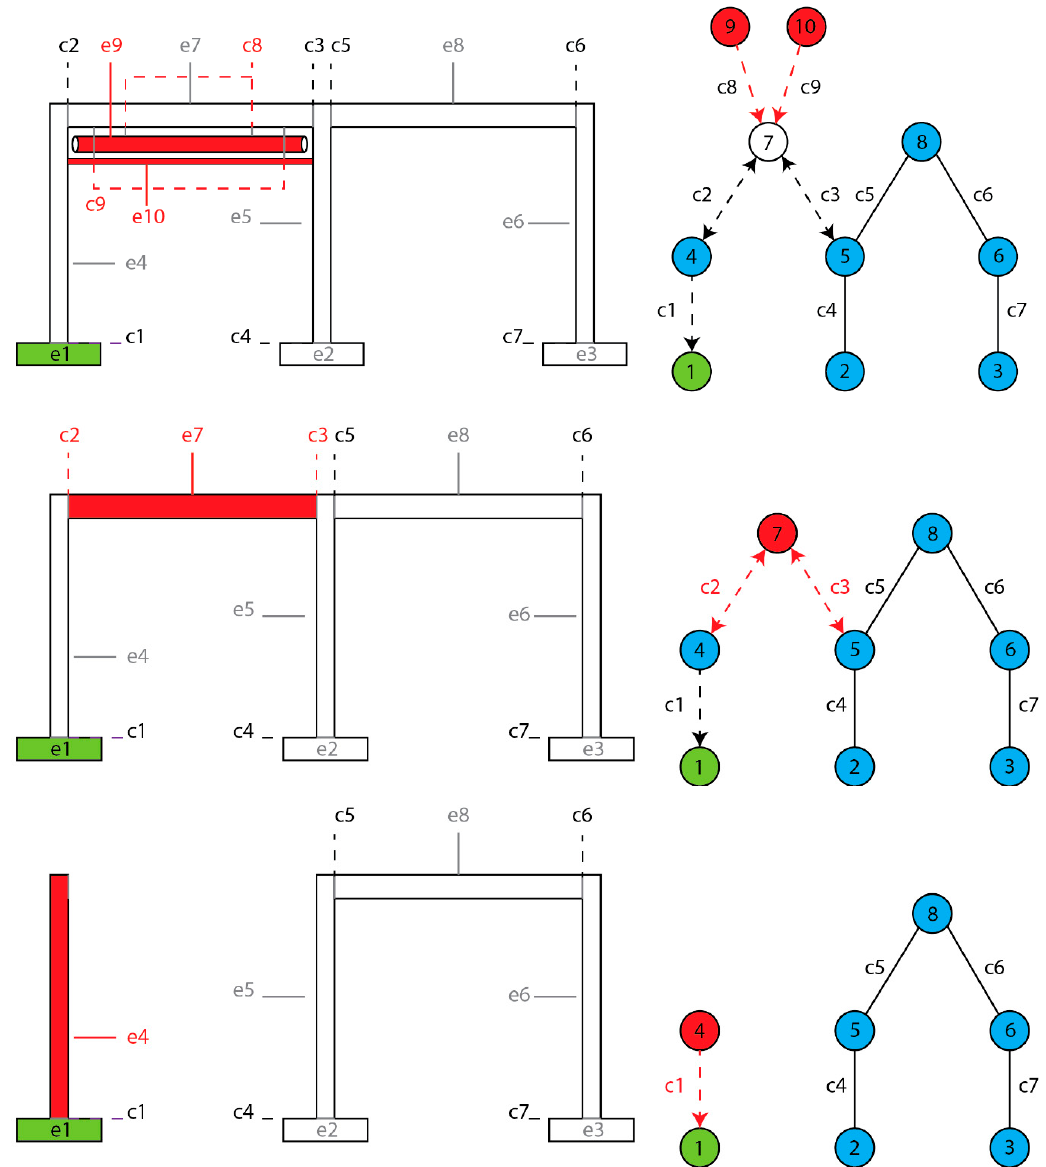
Figure 10. The disassembly sequence (represented by the succession of illustrations above) to get element e1 (the foundation of the column) does not only rely on the removal of the column e4 but also on all the others elements depending on this column.